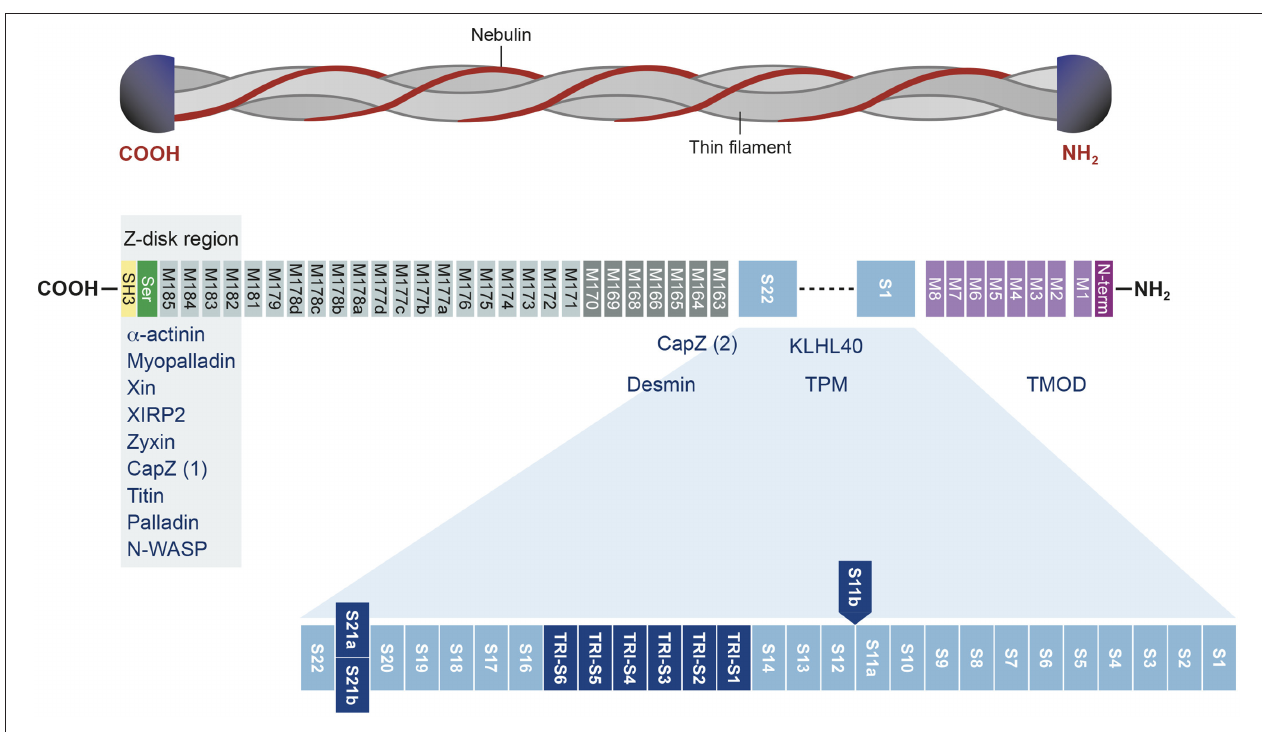
FIGURE 1 | Structure of the nebulin protein and binding partners. Nebulin gene consists of multiple repeat modules (M) that contain actin-binding domain. The S21 super repeat encodes the mutually alternatively spliced exons 143 and 144 and contains the binding site for KLHL40. The C-terminal is anchored in the Z-disk region of the sarcomere and contains a conserved serine-rich homology domain (SH3). This terminal region binds many muscle proteins. Binding partners are written in blue. Adapted from Yuen and Ottenheijm (39),